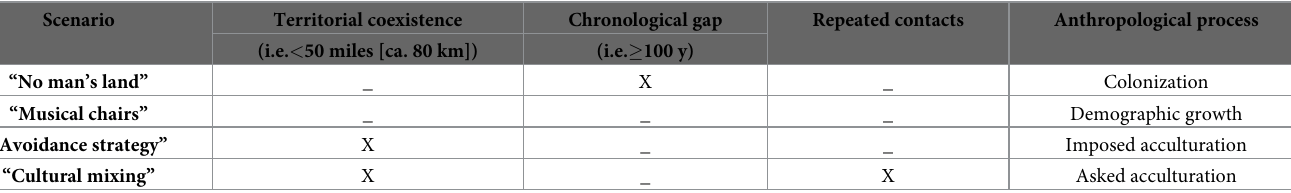
Table 3. Main characteristics of the different models of potential